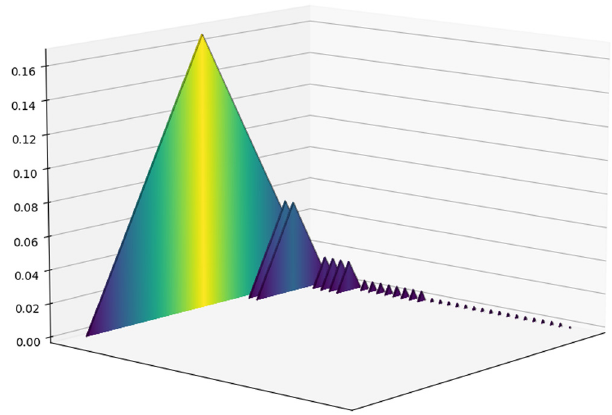
from the persistence landscape of the middle third Cantor set (cid:4) Figure 2: Graph of the functions f f ,…, 2 33